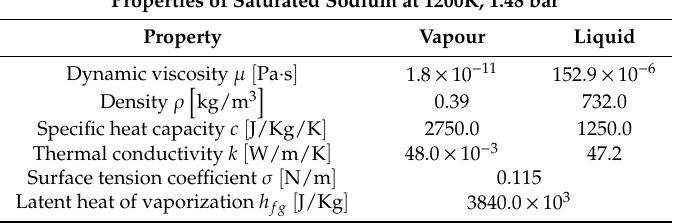
Table 2. Properties of saturated sodium at 1200K in near-atmospheric conditions typical of reactor operation.